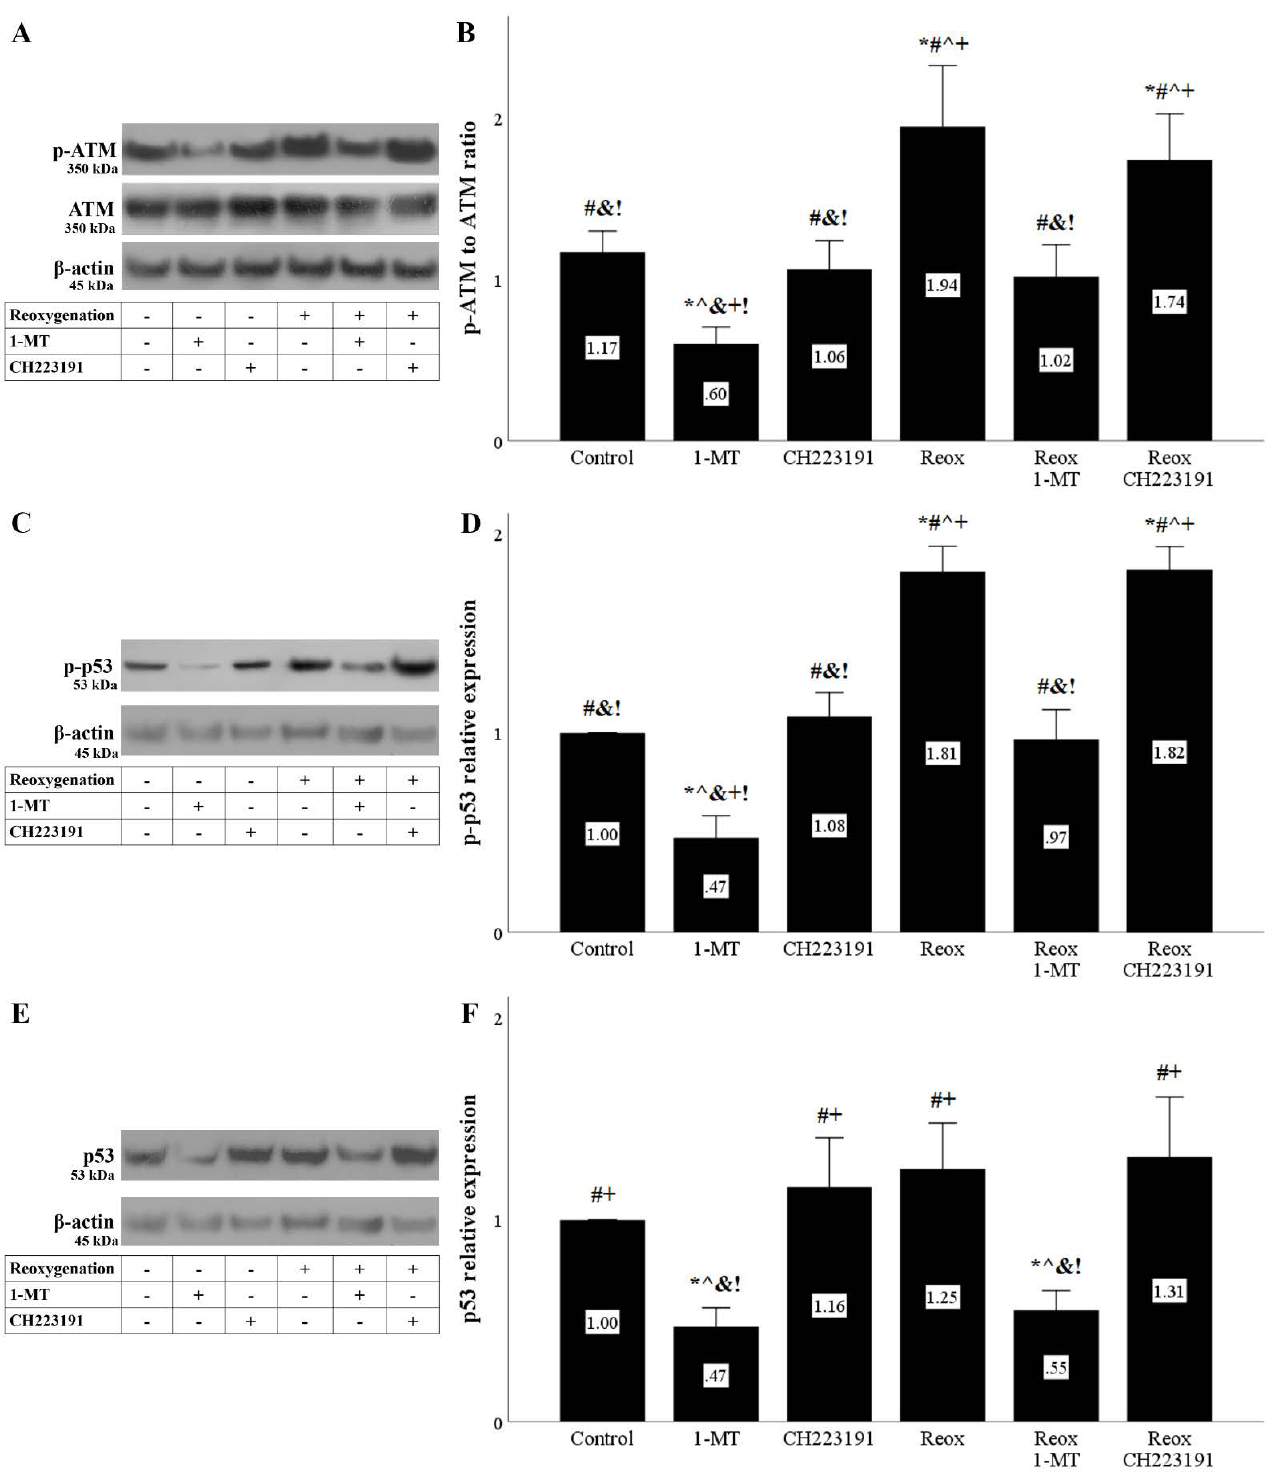
Figure 6. Reoxygenation induces DNA damage response that is ameliorated by inhibition of IDO. Cells were cultured under anoxic conditions for 24 h and then subjected to 2 h of reoxygenation along with the indicating treatments. Reoxy- genation induced a DNA damage response assessed by the level of phosphorylated activated ATM. 1-MT, but not CH223191, prevented p-ATM upregulation. A representative Western blot experiment is displayed in panel ( A ), whereas panel ( B ) depicts the cumulative results of four repeated experiments. Reoxygenation increased p-p53 level. 1-MT, but not